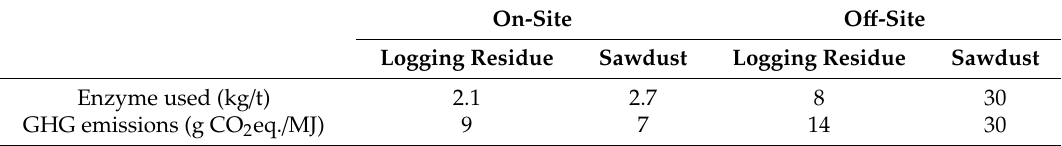
Table 4. Impact of changing enzyme configuration on ethanol life cycle GHG emissions.